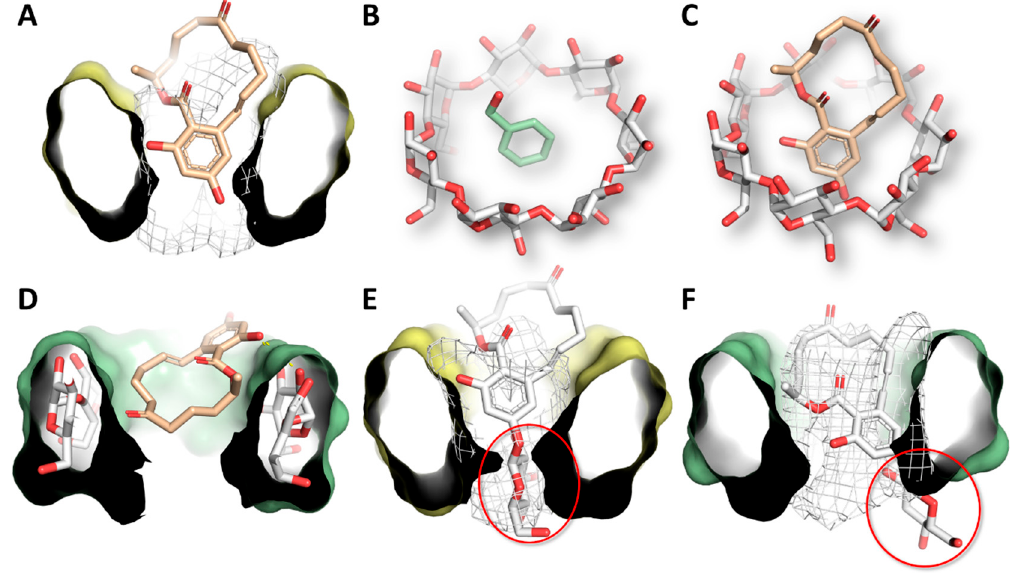
Figure 7. Representation of CD host–guest-type complexes. In most parts of the figure, CDs are represented as cut surfaces for the better clarity. ( A ) Representation of the calculated ZEN-BCD complex. The white mesh indicates the hydrophobic space of the BCD cavity; ( B ) Crystallographic coordinates of phenyl alcohol-BCD complex (CCDC accession code DEBGOG); ( C ) Calculated pose of ZEN within BCD; ( D ) Representation of the calculated ZEN-GCD complex. GCD is represented as sticks and cut surface. Yellow dashed lines indicate polar interaction; ( E ) Representation of the calculated Z14G-BCD complex. The white mesh indicates the hydrophobic space of BCD cavity while the red ring indicates the glucoside group of Z14G; ( F ) Representation of the calculated Z14G-GCD complex. The white mesh indicates the hydrophobic space of GCD cavity, while the red ring indicates the glycoside group of Z14G.